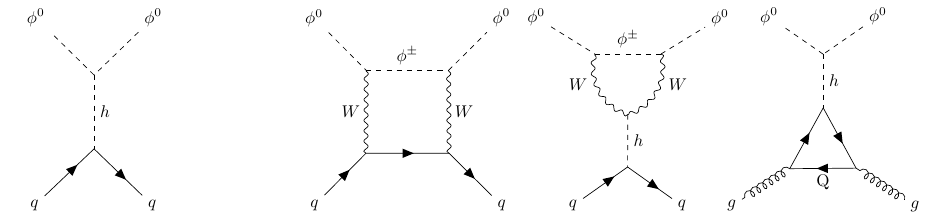
Figure 2: Representative Feynman diagrams for dark matter scattering with quarks / gluons at tree and one loop